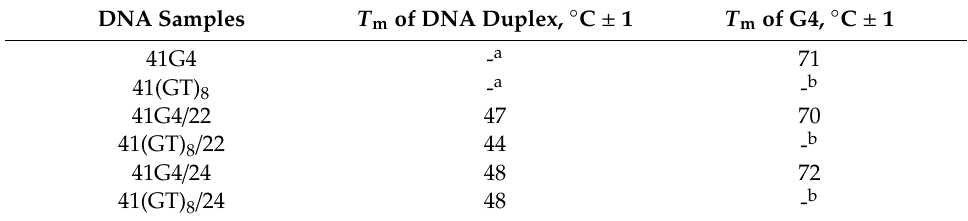
Table 1. T m values determined from differential UV melting curves for a G4 (at 295 nm) and DNA duplex (at 260 nm) domains in buffer A.